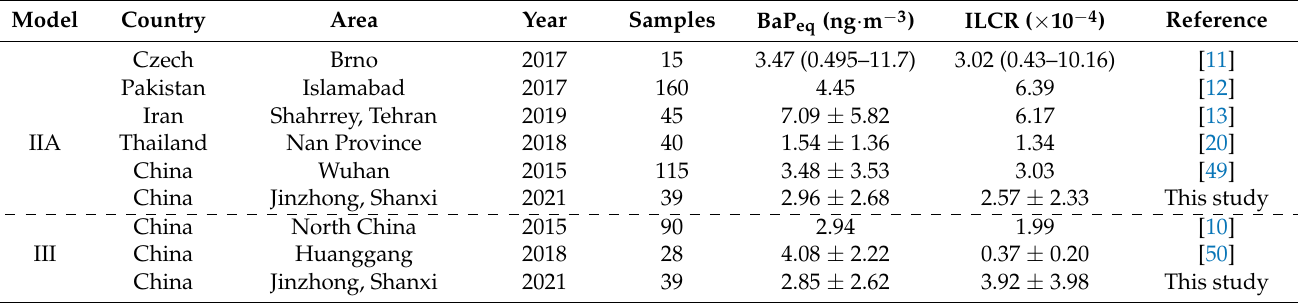
Table 3. Mean concentrations ( ± standard deviation) or range (min–max) of BaP eq and cancer risks for adult from the inhalation exposure of PM 2.5 -bound 16 PAHs compared to other countries and